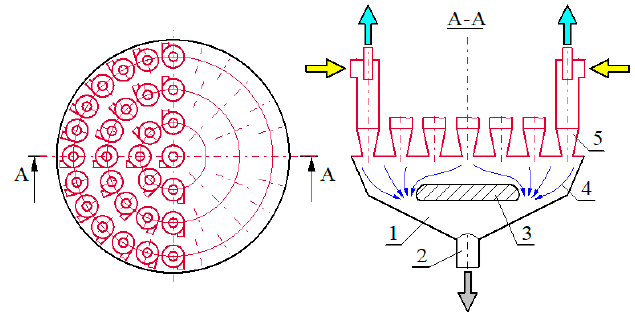
Figure 7. Sedimentation tank diagram with an intermediate inlet to the suction pipe: 1— sedimentation tank, 2—suction hose connector, 3—partition (deflector), 4—stream lines, 5—cyclone.